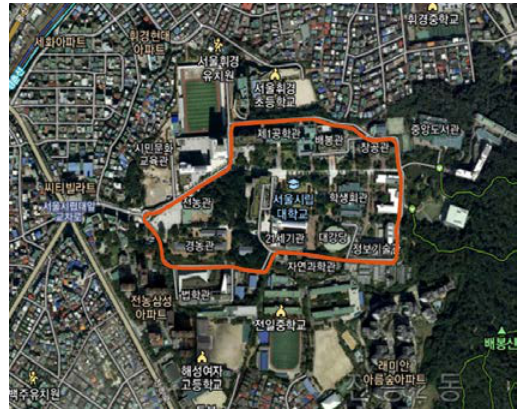
Figure 4. The test site and trajectory (red